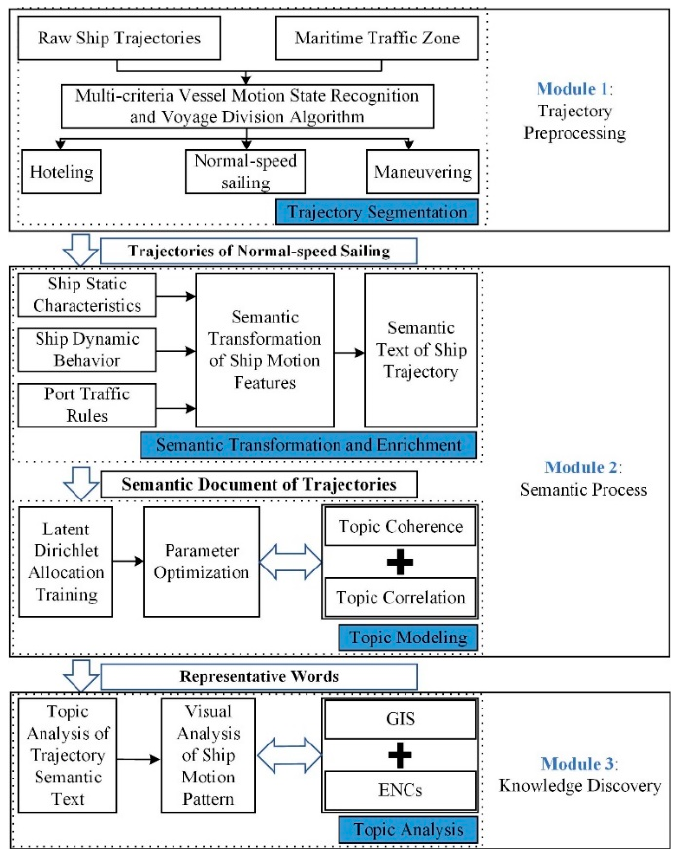
Figure 1. Framework of the semantic recognition method for ship motion patterns entering and leaving the port.